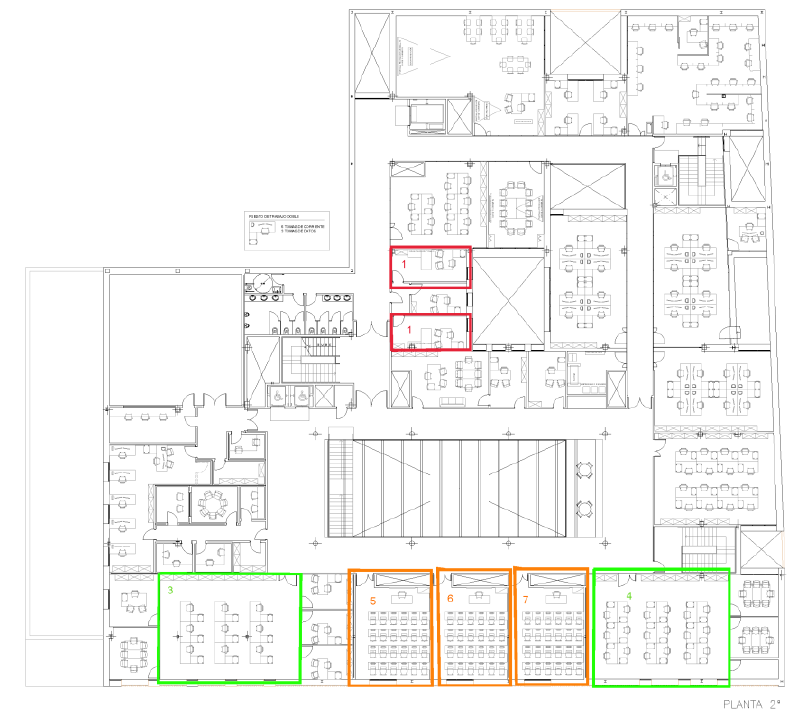
Figure 8. Situation of the offices in which the case study is carried out.